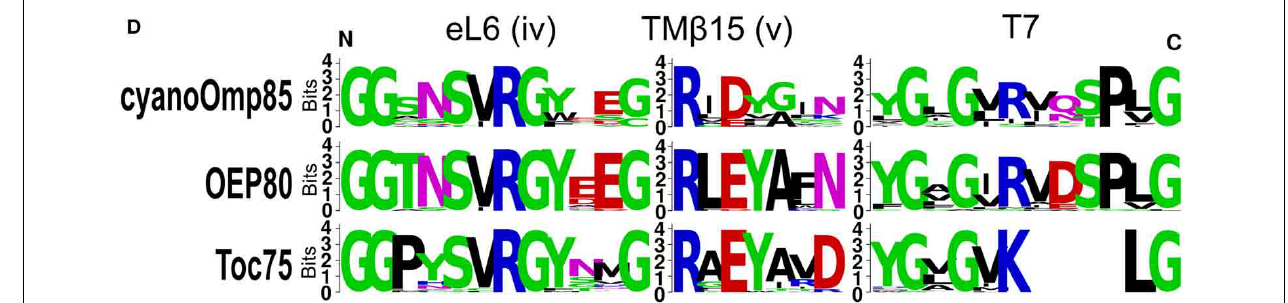
FIGURE 2 | Predicted structures of chloroplast Omp85 homologs. (A) An alignment of the POTRA domains of two cyanoOmp85 orthologs with known structure and four chloroplast Omp85 homologs from the flowering plant A. thaliana (AtOEP80 and atToc75) and the green alga Coccomyxa subellipsoidea (CsOEP80 and csToc75). Shown above the alignment is the resolved secondary structure of Omp85 from Nostoc sp. PCC7120 (Koenig et al., 2010). POTRA domains 1–3 are indicated as P1-3, respectively. The horizontal arrows with β indicate β -strands. The coils show α -helices (indicated with α ) or a 3–10 helix (indicated with η ) found in the C terminus of the 1st helix of P2. The residues located at turns are indicated with T. Sequences conserved in OEP80 and cyanoOmp85 but diverged in Toc75 (i,iii) as well as an apparent insert at the N terminus of P2 of land plant Toc75 (ii) are indicated. The two vertical arrows below the alignment indicate the